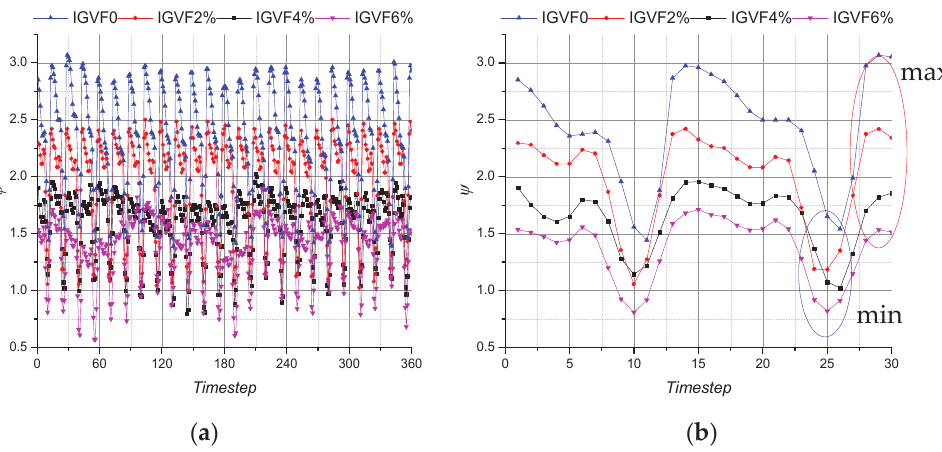
Figure 11. Head fluctuation curve. ( a ) The fluctuation in a completed revolution ( b ) The maximum and minimum point